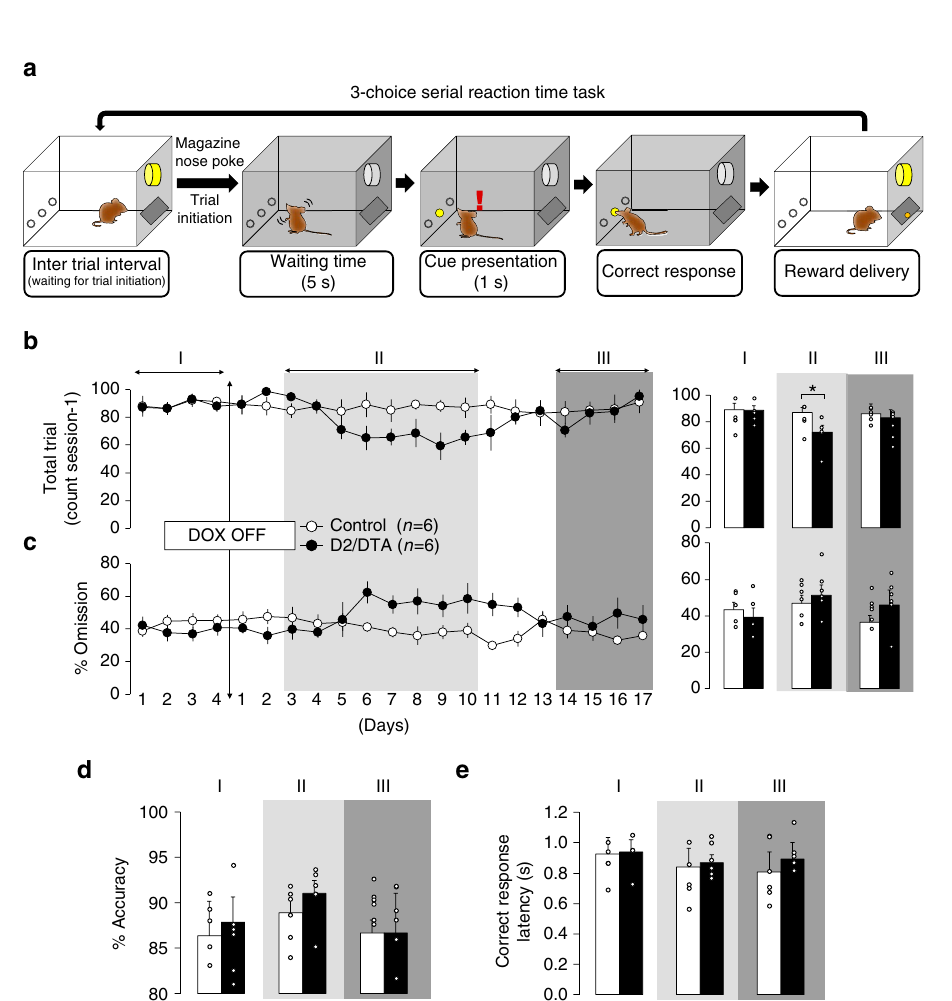
Figure 4 | Expansion of VLS D2-MSN loss-of-function initially produces a reduction of goal-directed behaviour. ( a ) Schematic illustrations of the 3-CSRT task sequence. ( b – e ) The temporal changes of behavioural parameters induced by DOX-off manipulations in the 3-CSRTT. The black circles represent data from the bigenic group ( n ¼ 6) and the white circles represent data from monogenic controls ( n ¼ 6). The bar graphs show the behavioural parameters averaged over (cid:3) 3 to 0 days before (phase I), 3–10 days after (phase II) and 14–17 days after (phase III) DOX termination in the 3-CSRTT. Decreased total number of trials ( b ) and a trend of increased % omissions ( c ) were observed only during phase II. DOX removal did not change ( d ) % accuracy or ( e ) correct response latency, indicating that divided attention and motor function were spared after DOX removal. Bars represent the mean and lines represent the GFP (Supplementary Fig. 6D). The pyramidal neurons are known IC were not labelled with GFP (Supplementary Fig. 6E). to express Drd2 mRNA, and their axon terminals project to the Altogether with these data, ArchT expression within the striatum striatum; however, neurons in the medial prefrontal cortex and was specific to the D2-MSNs (Supplementary Table 1).